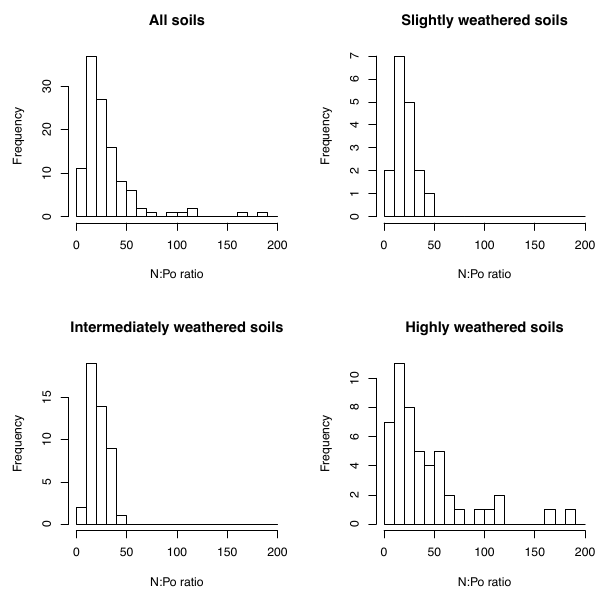
Fig. 5. Histograms of N:Po ratios in soils of all weathering stages, slightly weathered soils(Andisols, Histosols, Entisols, and Incepti- sols), intermediately weathered soils(Aridsols, Vertisols, Mollisols, and Alfisols) and highly weathered soils(Spodosols, Ultisols, and